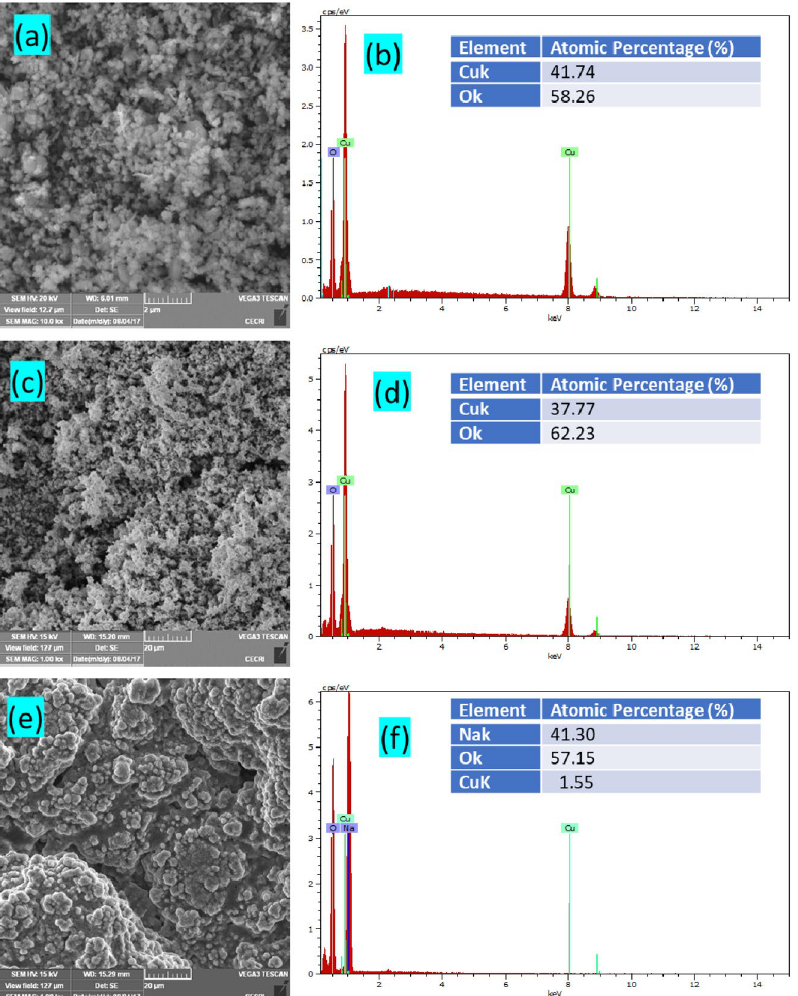
Figure 2. ( a , c , e ) SEM images and ( b , d , f ) EDS spectra of Cu 2 O, CuO and CuNa 2 (OH) 4 nanoparticles,